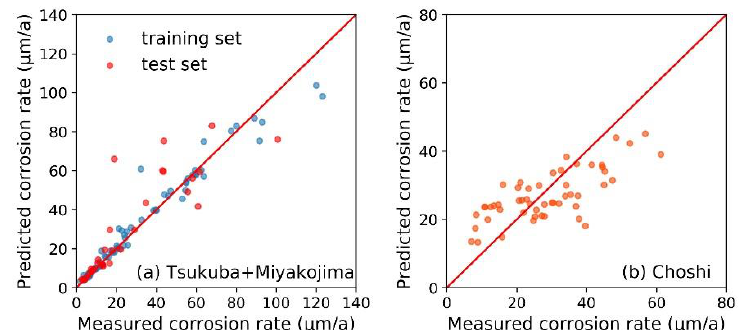
Figure 5. The random forest algorithm-based corrosion rate prediction model for steel samples under the open environment. ( a ) The model was trained and tested by the corrosion data of Tsukuba and Miyakojima. ( b ) The model’s generalization ability was evaluated by verifying its prediction accuracy to the same steel samples in Choshi.